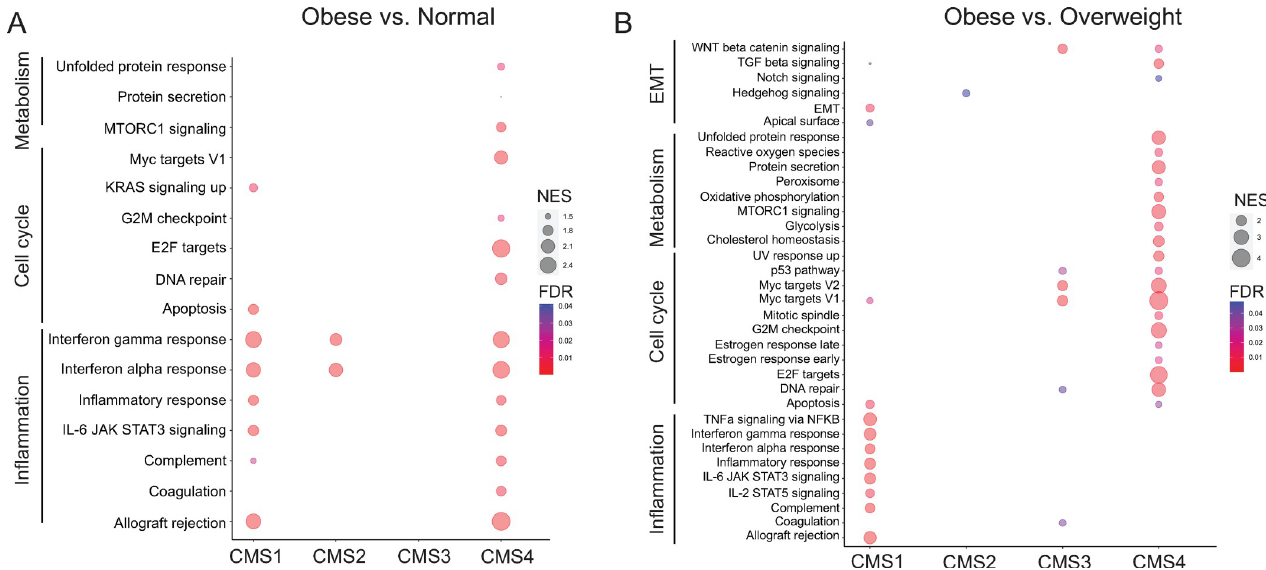
Fig 4. Gene set enrichment of Hallmark gene sets reveal CMS-specific differences between obese BMI groups. Normalized RNA-seq counts obtained from DESeq2 were used for Gene Set Enrichment Analysis (GSEA). Hallmark gene sets were assessed in the obese vs. normal (A) and obese vs. overweight (B) comparisons for each CMS category. Bubbles for gene sets with a false discovery rate q-value less than 0.05 were reported. The size of bubbles represents the normalized enrichment score (NES). The color of bubbles represents false discovery rate q-value (FDR).